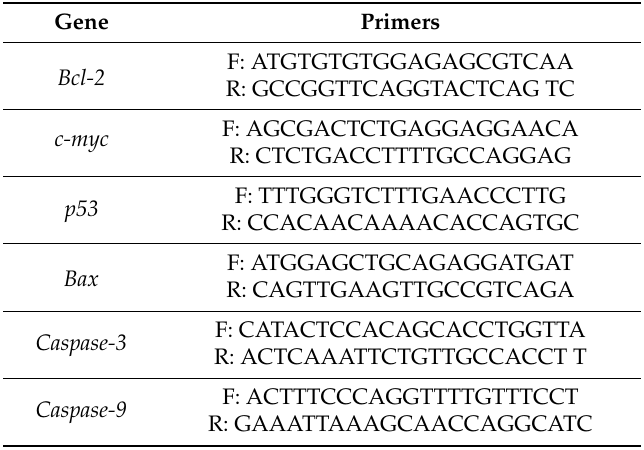
Table 1. List of primers used in this